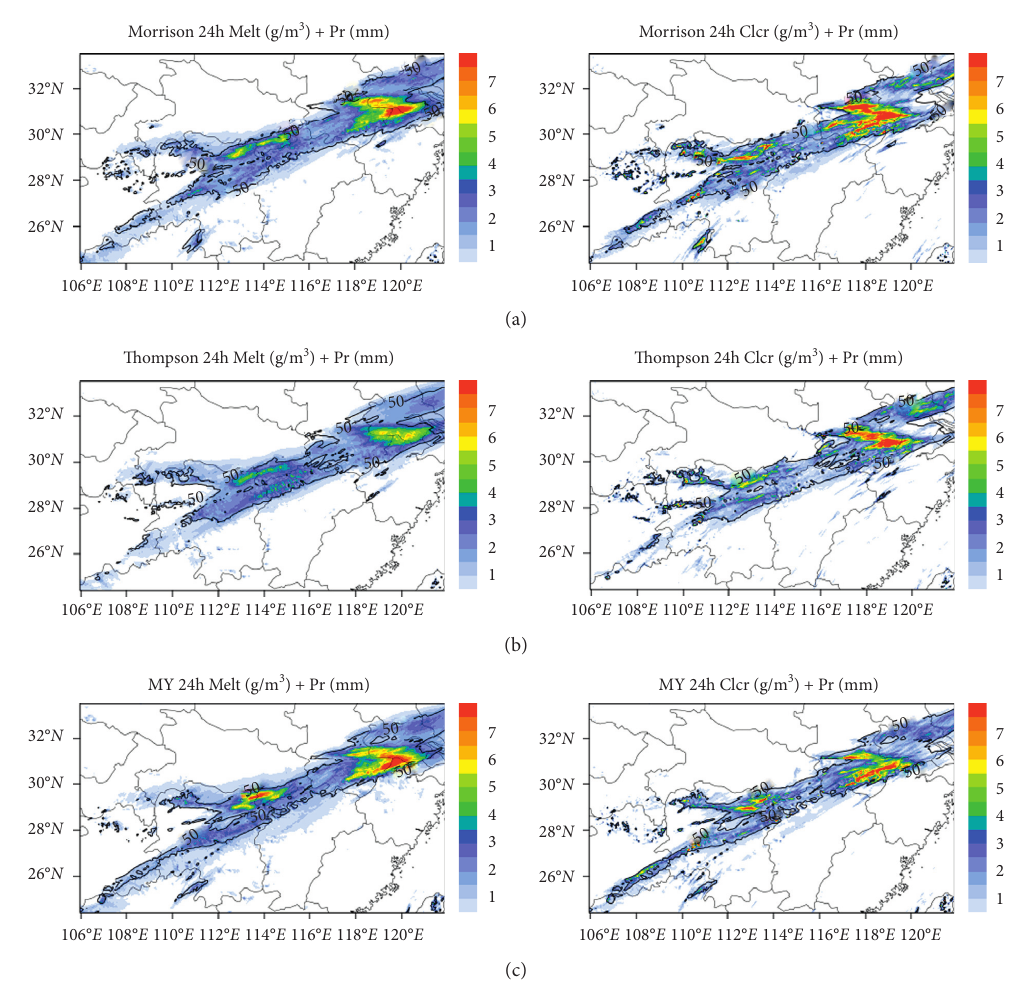
Figure 11: Vertically averaged h_ave_Mlt and h_ave_CLcr (shaded area) and heavy rainfall area (contour of 50 mm): (a), Morrison; (b) Thompson; (c) MY. 1 and 2 indicate melting of ice-phase hydrometeors and accretion of cloud droplet by rain,